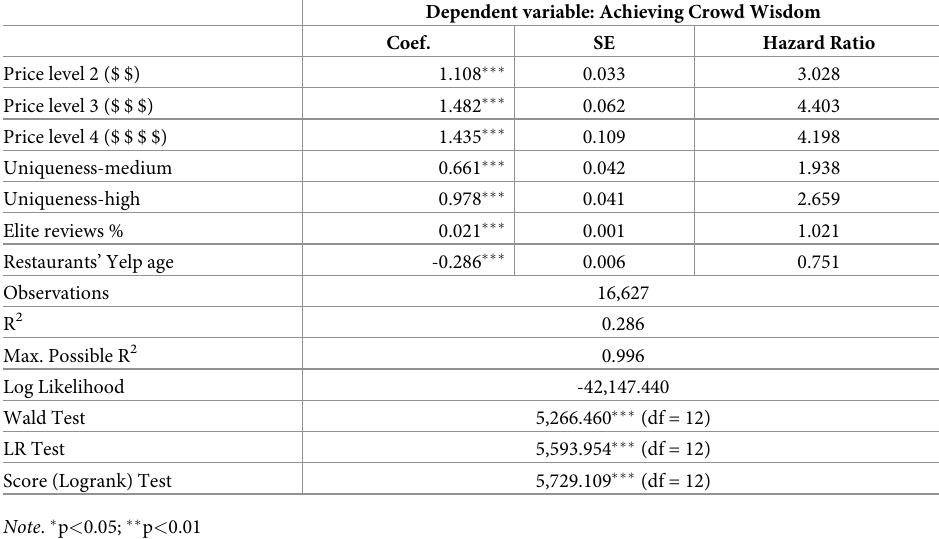
Table 4. Results of cox proportional hazards model predicting the incidence of achieving crowd